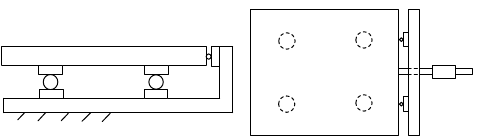
Figure 8. The rolling friction experiment system model.